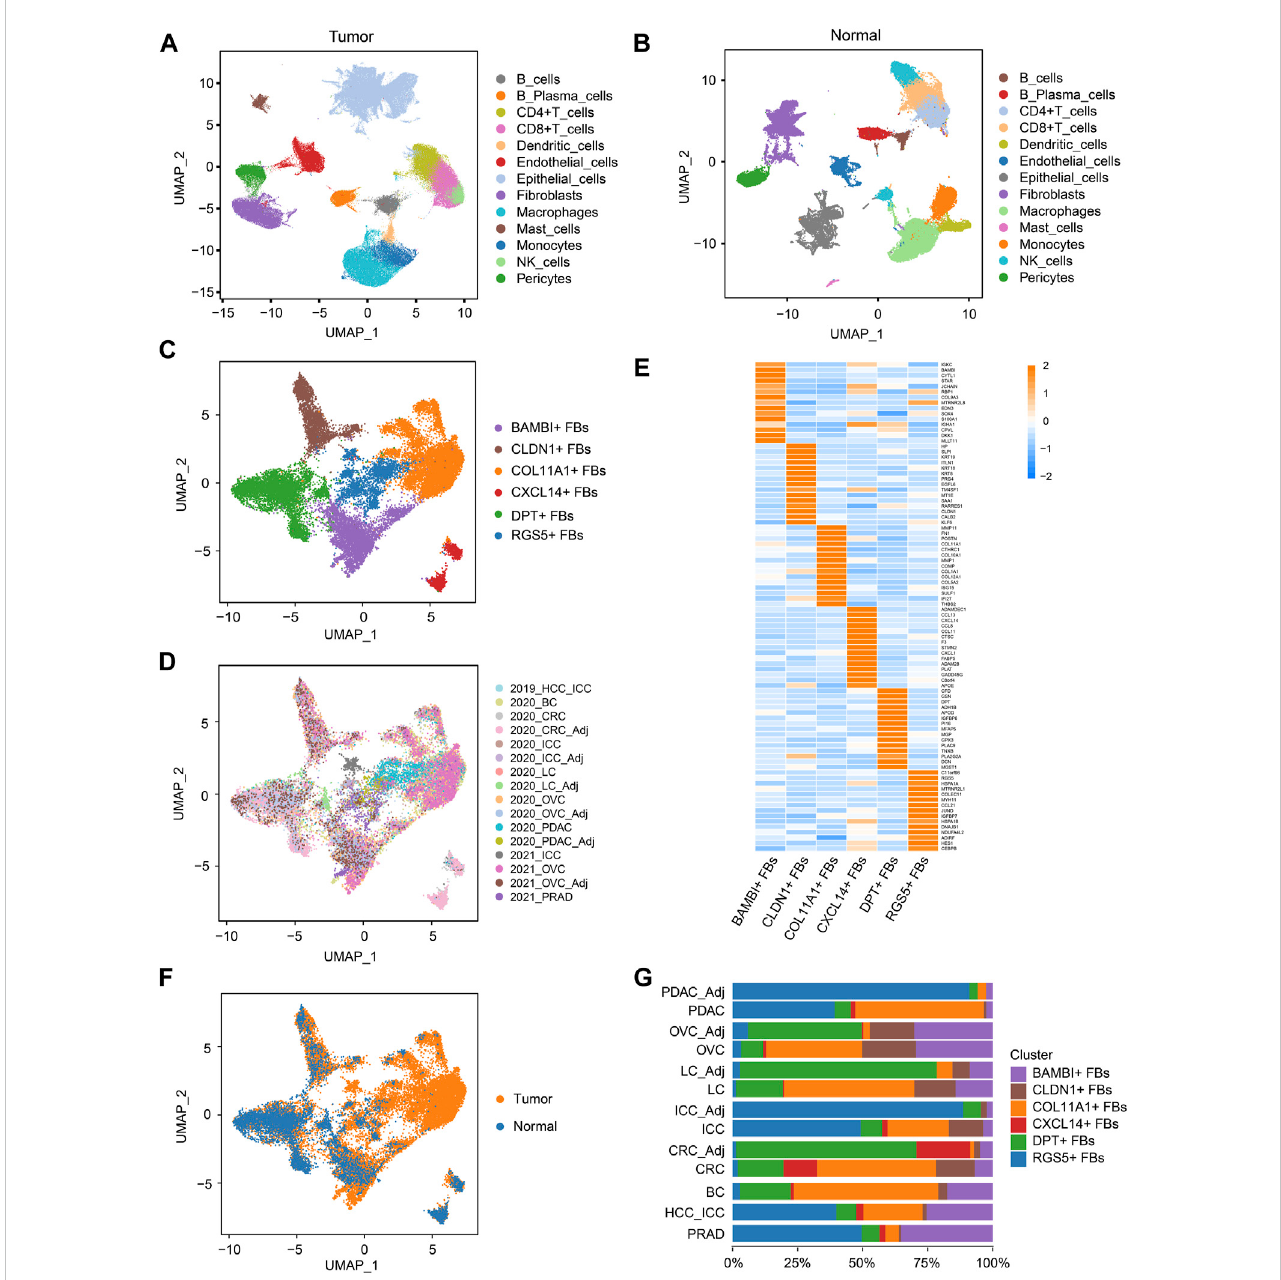
FIGURE 2 COL11A1 + fi broblasts speci fi cally exist in tumor tissues. (A) , UMAP visualization of the cell populations in tumor tissues from ten scRNA-seq datasets acrosseighttumortypes. (B) ,UMAP visualization ofthecellpopulationsfromsixscRNA-seqdatasetsof fi vetypesofnormaltissues. (C) ,UMAP visualization of fi broblastclustersacrossnormaltissuesandtumortissues.Different fi broblastclustersarecolor-coded. (D) ,UMAPtodepictthetissueoriginsofthe fi broblast clusters. (E) , Heatmap to show the top DEGs (Wilcoxon test) in each fi broblast cluster. (F) , UMAP to depict the tissue types (tumor or normal tissue) of different fi broblast clusters. (G) , Bar plots to show the proportion of different fi broblast clusters in each tissue. DEGs, differentially expressed